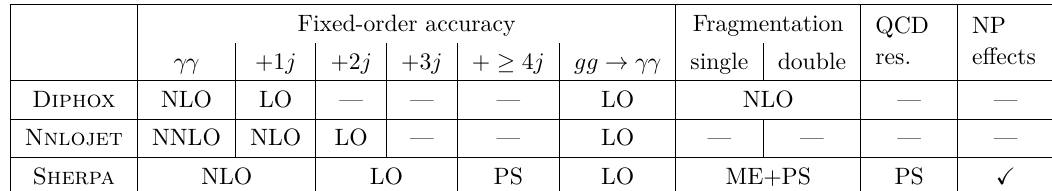
Table 4. Overview of the theory predictions and their relevant features. The label ‘QCD res.’ (‘NP effects’) stands for QCD resummation (non-perturbative effects).